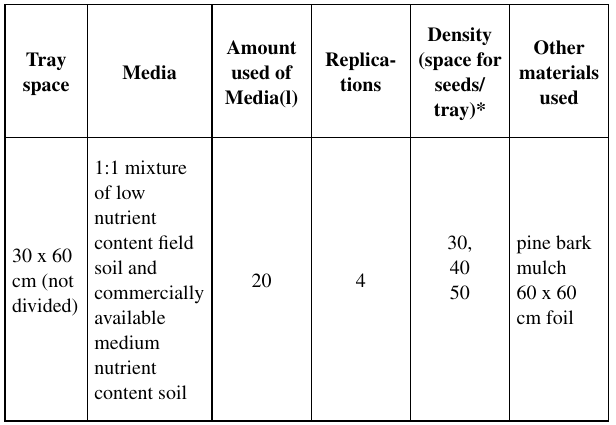
Table 1 : Details of the materials requirements of the Nurse in tray